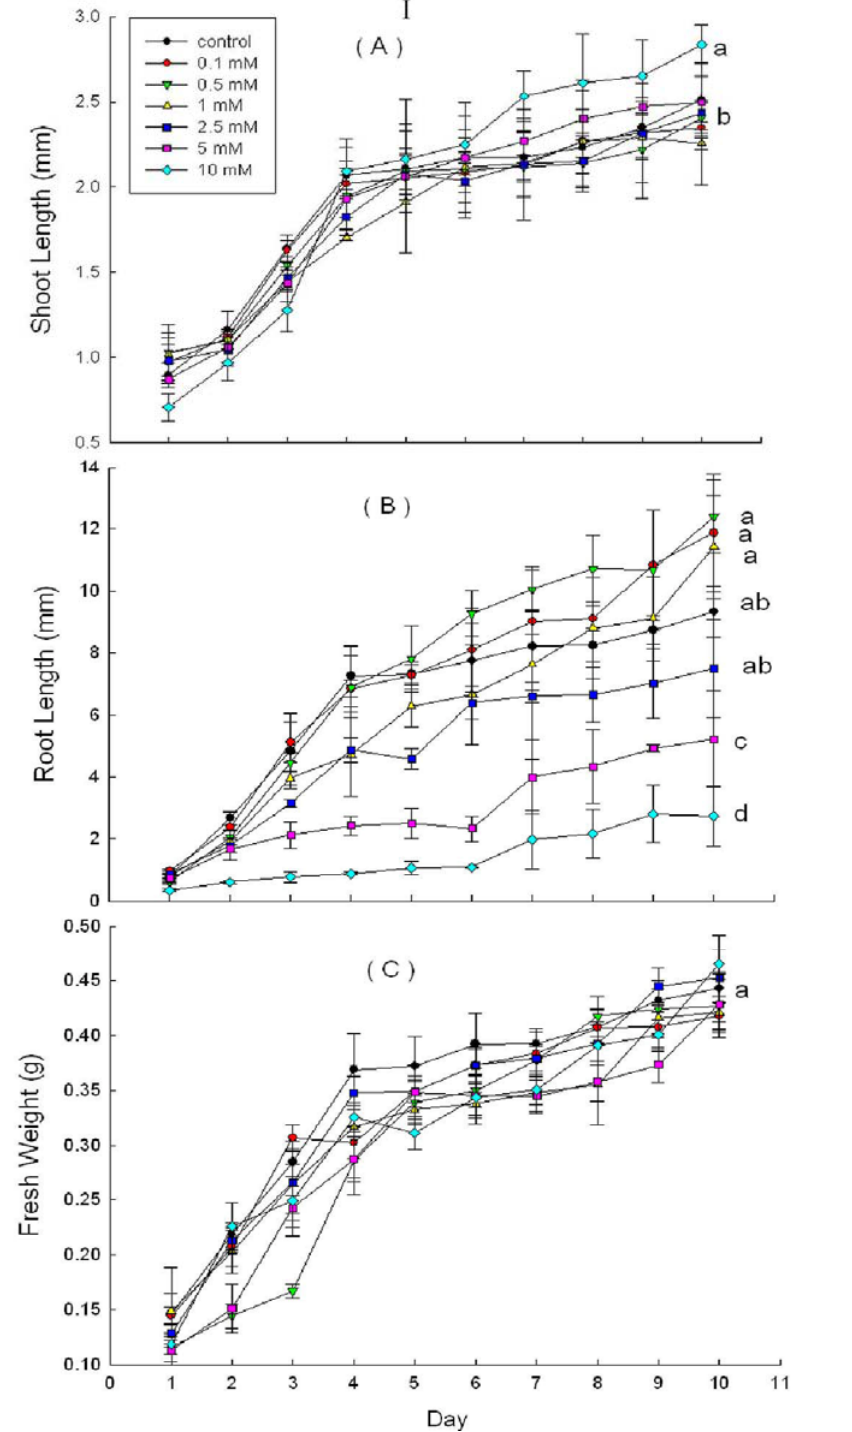
Figure 5. Effects of DHAP on shoot length ( a ), root length ( b ) and fresh weight ( c ) of radish (I), cucumber (II) and mung bean (III); Line graphs within the same plot followed by the same letter are not different at P = 0.05 level according to Fisher’s test; Each point is the mean of three replicates ±